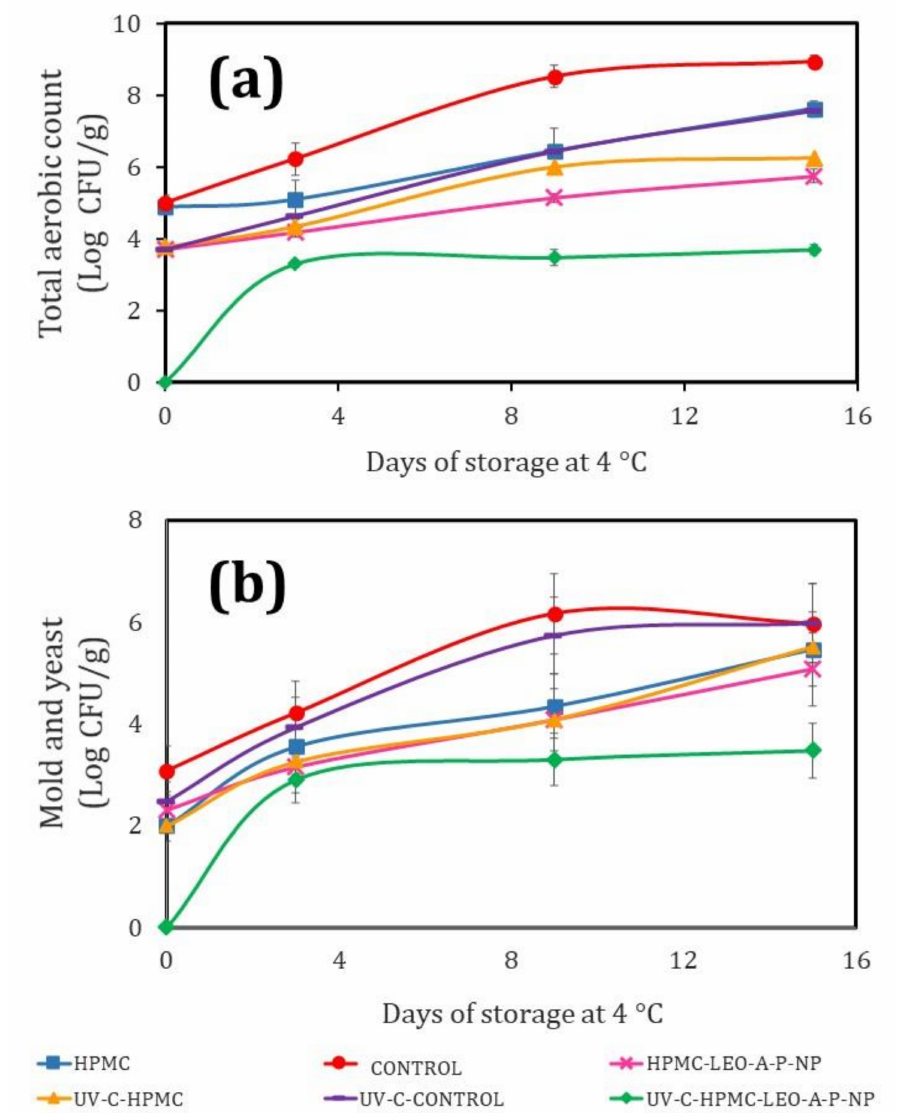
Figure 5. ( a ) Effect of nano-coating on the growth of aerobics and ( b ) mold and fungi on fresh-cut cucumber at 4 ◦ C for 15